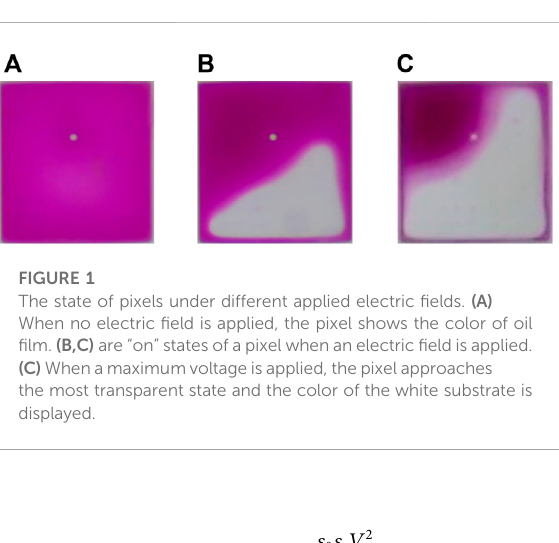
Where θ 0 is the initial solid – liquid interface contact angle, θ is the contact angle when the external voltage V is applied. ε 0 is the absolute dielectric constant. ε r and d are the relative permittivity and thickness of the dielectric layer, respectively. σ is the